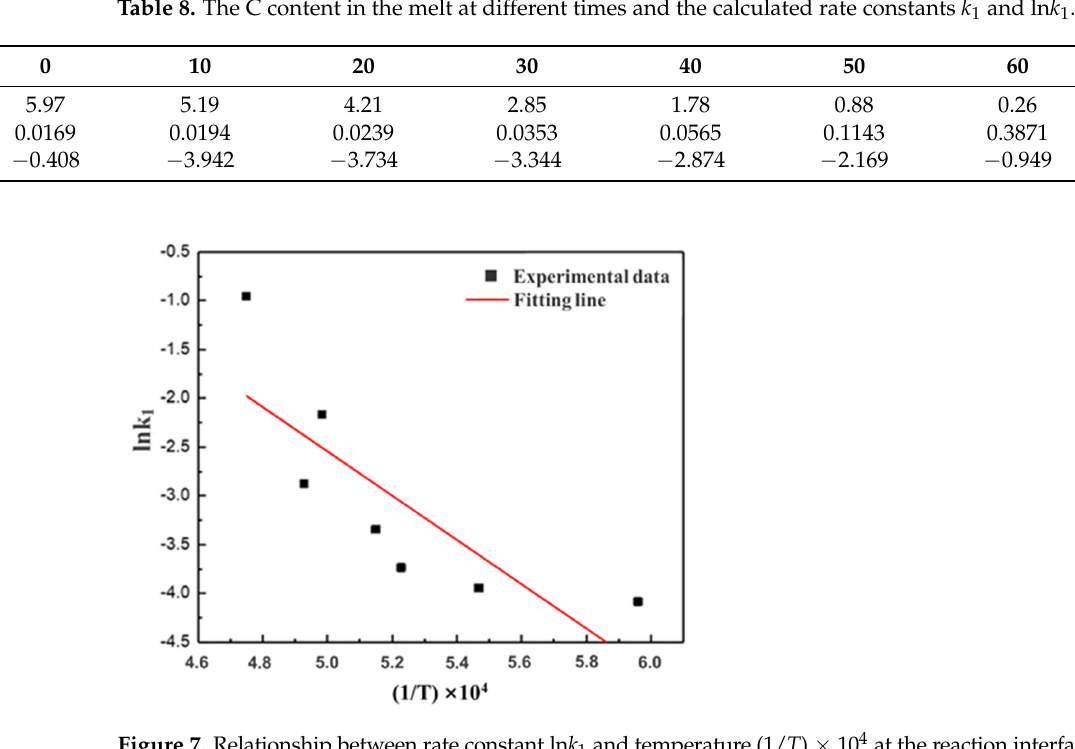
Figure 7. Relationship between rate constant lnk 1 and temperature (1/ T ) × 10 4 at the reaction inter ‐